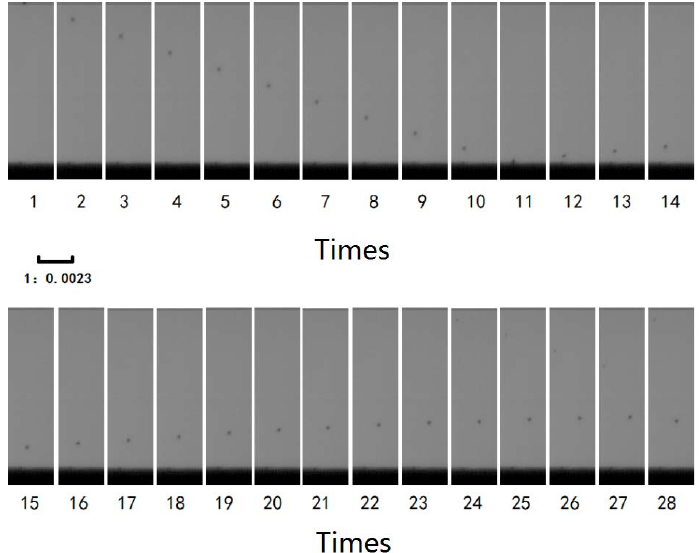
particle on a flat 2